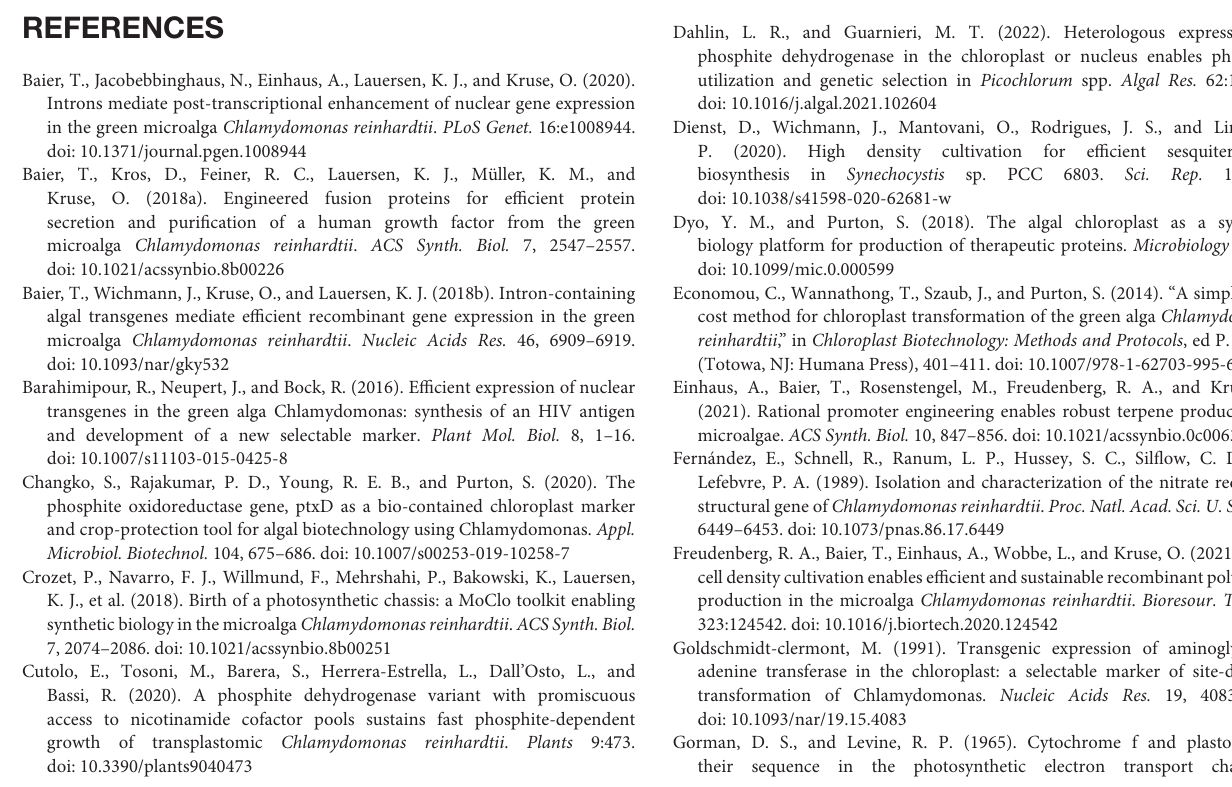
Supplementary Figure 3 | Confirmation of pPO3 integration into the chloroplast genome of UVM4 in derivative strains UVM4-Phi and UPN22. Primers Fw: